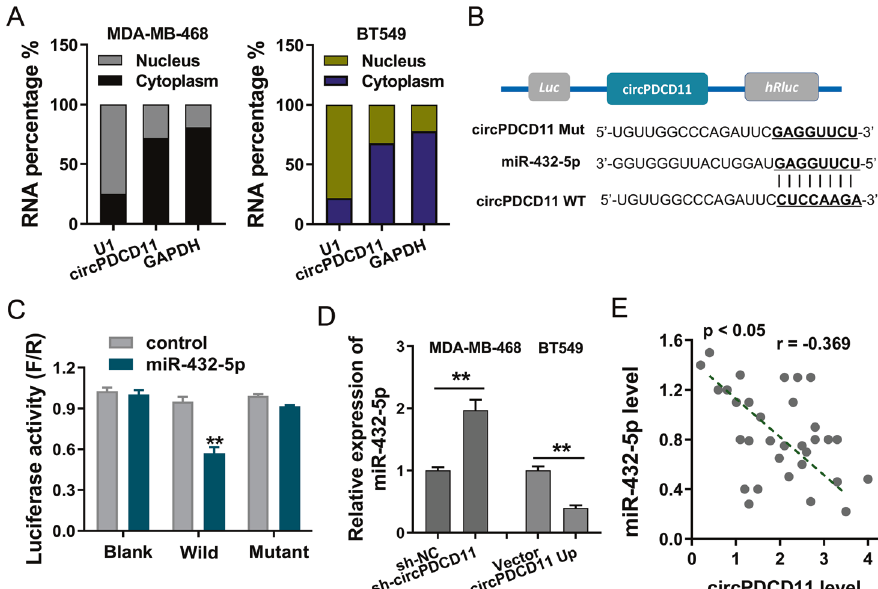
Fig. 4 circPDCD11 was identi fi ed to target miR-432-5p. A The nuclear and cytoplasmic fractions of circPDCD11 were assessed using RT- qPCR in TNBC cells (MDA-MB-468, BT549). B The downstream target element of circPDCD11 was predicted using CircInteractome (https:// circinteractome.nia.nih.gov/), which revealed that miR-432-5p displayed the complementary binding sites for circPDCD11. C A luciferase reporter assay demonstrated the intermolecular interaction ( fi re fl y/Renilla) in 293 T cells transfected with circPDCD11 wild type or mutant and miR-432-5p mimics or controls. D RT-PCR demonstrated the expression of miR-432-5p in MDA-MB-468 cells transfected with a circPDCD11 knockdown (sh-circPDCD11) and in BT549 cells overexpressing circPDCD11 (circPDCD11 up). E Clinical correlation analysis calculated by Pearson ’ s correlation re fl ected the correlation between circPDCD11 and miR-432-5p in clinical samples (32 samples). The data are presented as the means ± SD. Asterisks indicate signi fi cant differences (** p < 0.01). Cell Death Discovery (2021)